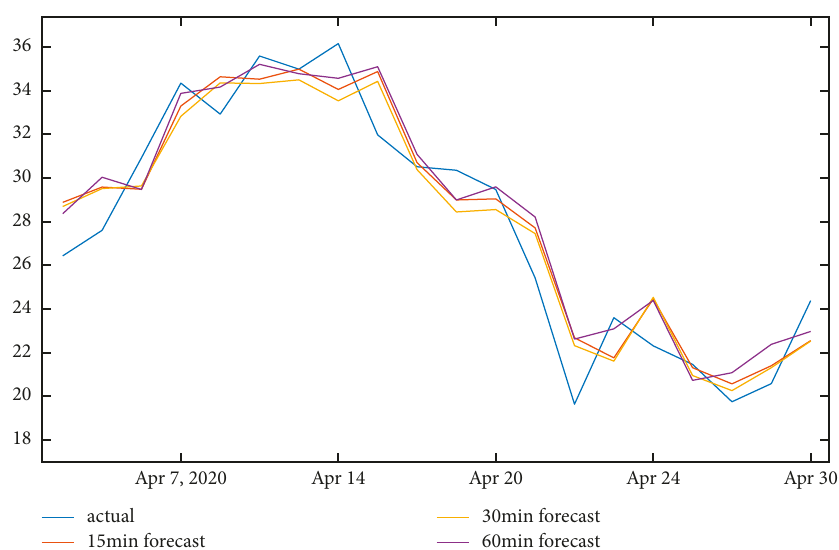
Figure 6: Actual and forecast price (USD per barrel) in different frequencies without night trading (February, 2020–May,